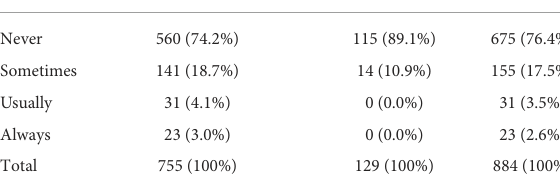
TABLE 3 Contingency table for discrimination feelings.